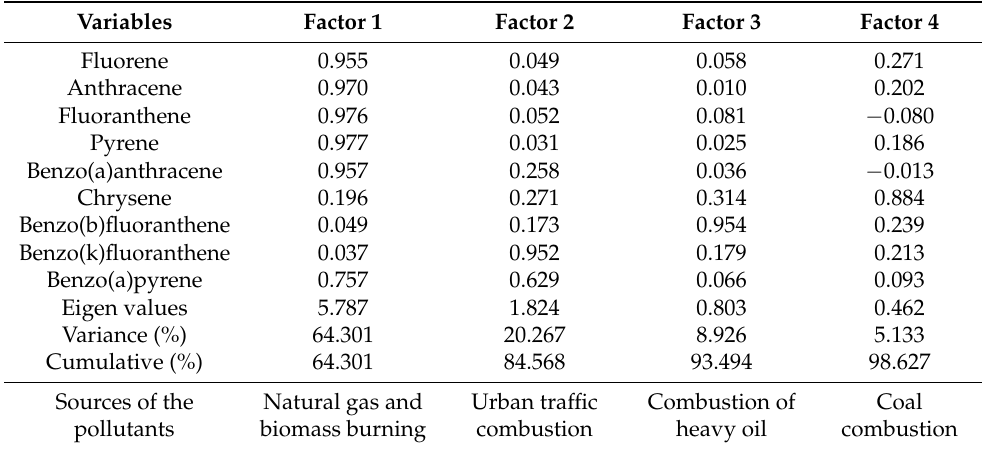
Table 3. The factor loadings of PAHs after PCA varimax rotation at the study